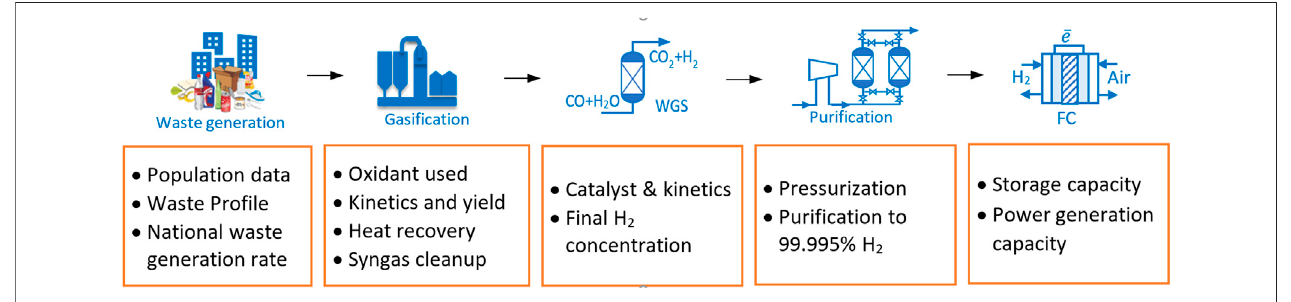
FIGURE 12 | Work fl ow on the waste-to-hydrogen concept